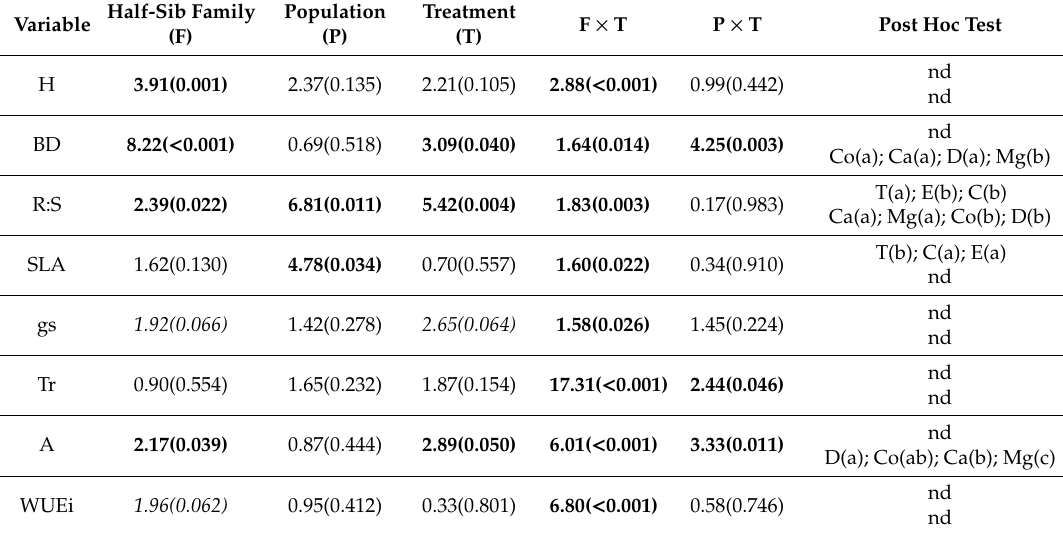
Table 3. Summary statistics of the general linear model and p -values (F) for the e ff ect of the half-sib family within populations, the di ff erent populations (Toledo, T; Calderona, C; Espad à , E), and treatments (Control, Co; Drought, D; MgCO 3 , Mg; and CaCO 3 , Ca) on cork oak ( Quercus suber ) seedling performance. The numbers in bold indicate significant e ff ects ( p < 0.05) and italics denote marginally significant e ff ects ( p < 0.1). Di ff erent letters denote significant di ff erences in the post hoc test ( p < 0.05) and “nd” denotes no di ff erences ( p >